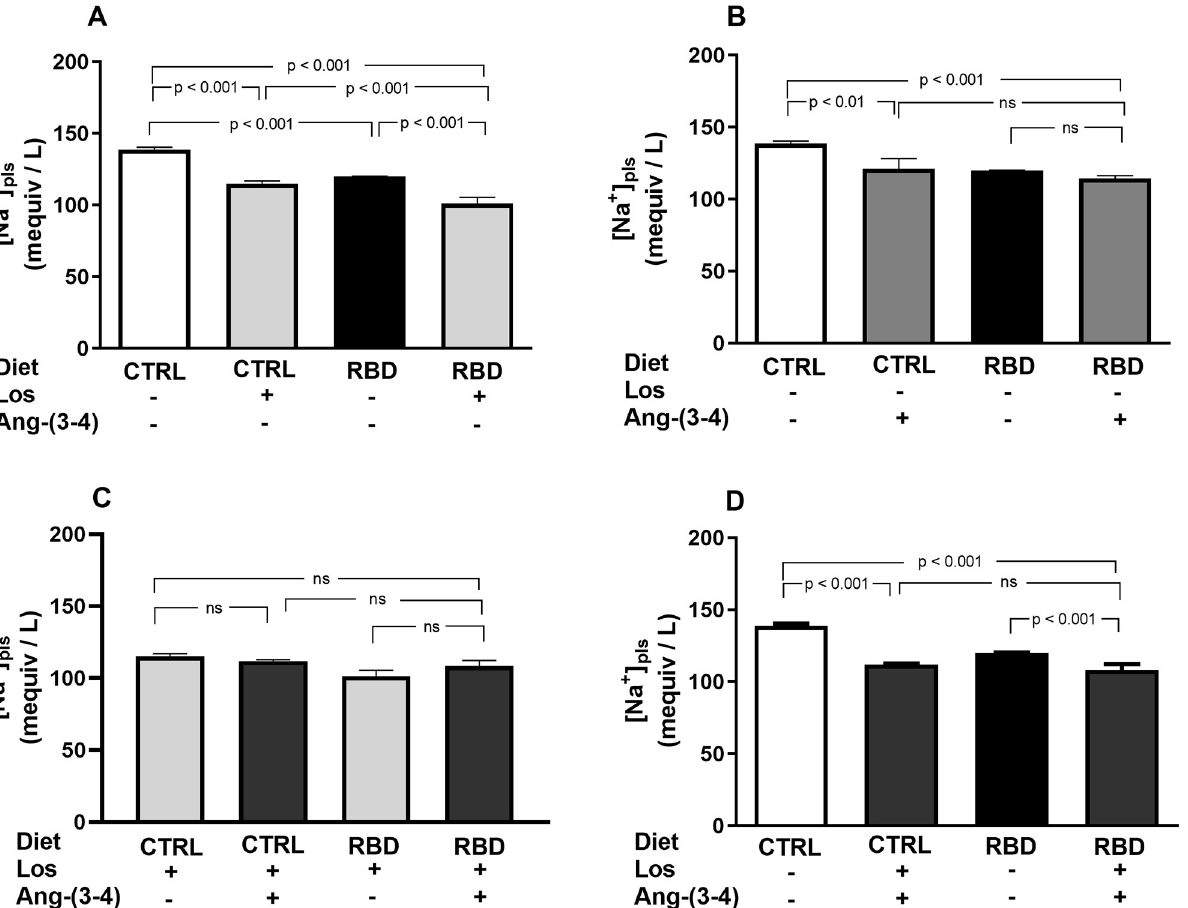
Fig 12. Plasma Na + concentration. Plasma Na + concentration ([Na + ] pls ) was determined in samples collected at 91 or 92 days (in the case of Ang-(3– 4)-treated rats). (A) Responses to Losartan. Comparison of [Na + ] pls in CTRL and RBD rats without chronic administration of Losartan, and effects of Losartan administration, as indicated on the abscissa . (B) Responses to Ang-(3–4). Effects of oral administration of a single dose of Ang-(3–4) on the [Na + ] pls of CTRL and RBD rats, as indicated on the abscissa . (C) Responses to Ang-(3–4) in rats previously treated with Losartan. Effects of oral administration of a single dose of Ang-(3–4) on the [Na + ] pls of CTRL and RBD rats previously treated with Losartan, as indicated on the abscissa . (D) Effects of combined Losartan+Ang-(3–4) administration. Comparison of [Na + ] pls between untreated CTRL and RBD rats vs . CTRL and RBD rats that were chronically given Losartan and a single dose of Ang-(3–4), as indicated on the abscissa . Bars are mean ± SEM; n = 5 (CTRL), n = 15 (RBD), n = 5 (CTRL+Los), n = 5 (RBD+Los), n = 5 (CTRL+Ang-(3–4)), n = 8 (RBD+Ang-(3–4)), n = 5 (CTRL+Los+Ang-(3–4)), n = 5 (RBD+Los+Ang-(3–4)). Differences between means were analyzed using one-way ANOVA followed by Bonferroni’s test for selected pairs. P values are given within the panels.